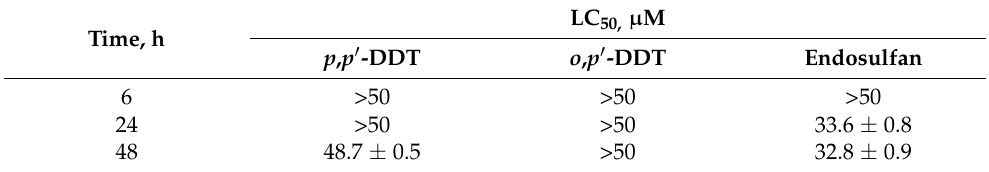
Table 4. The cytotoxicity (LC 50 ) of p , p (cid:48) -DDT, o , p (cid:48) -DDT, and endosulfan against MCF-7 cells. LC 50, µ M Time, h p , p (cid:48) -DDT